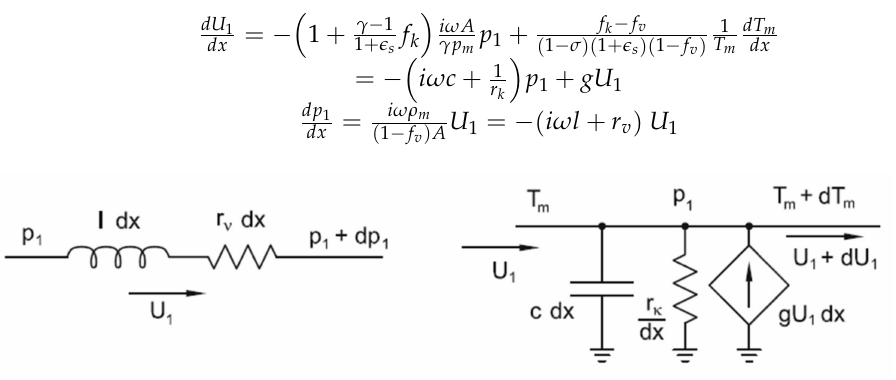
Figure 2. Electroacoustic analogy for linear continuity and momentum equations